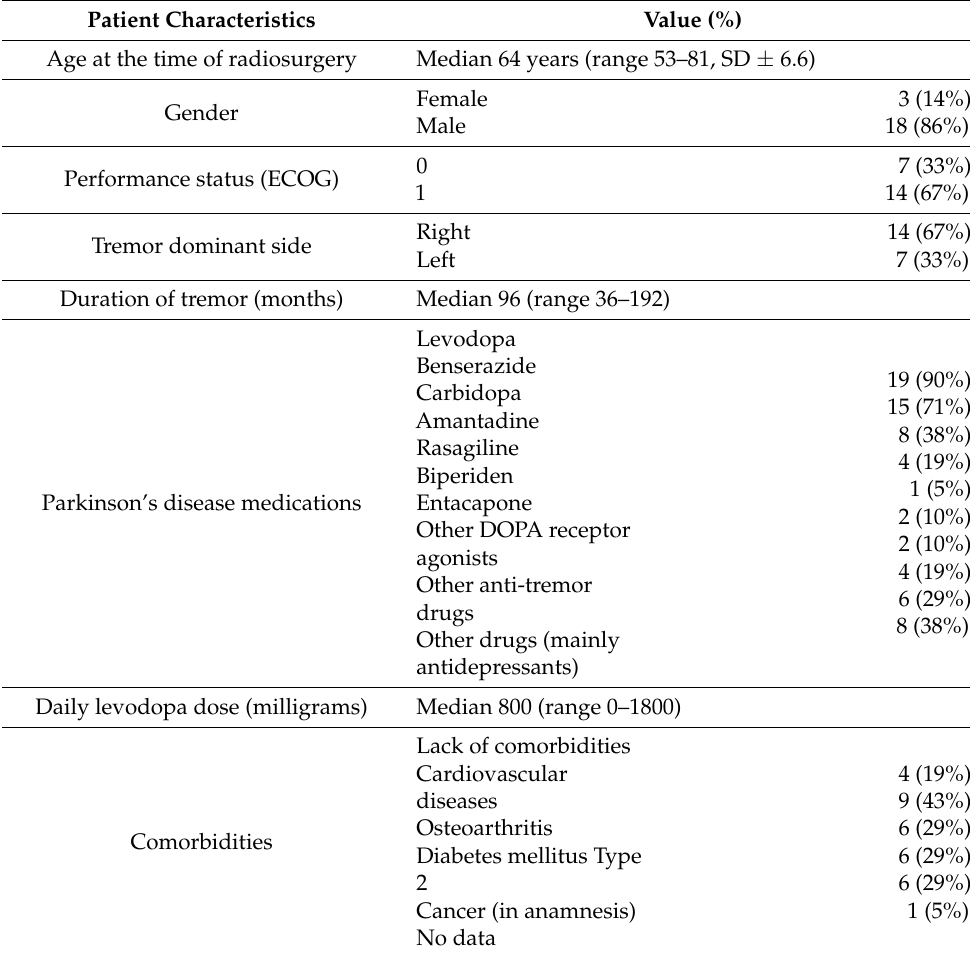
Table 2. Characteristics of the study